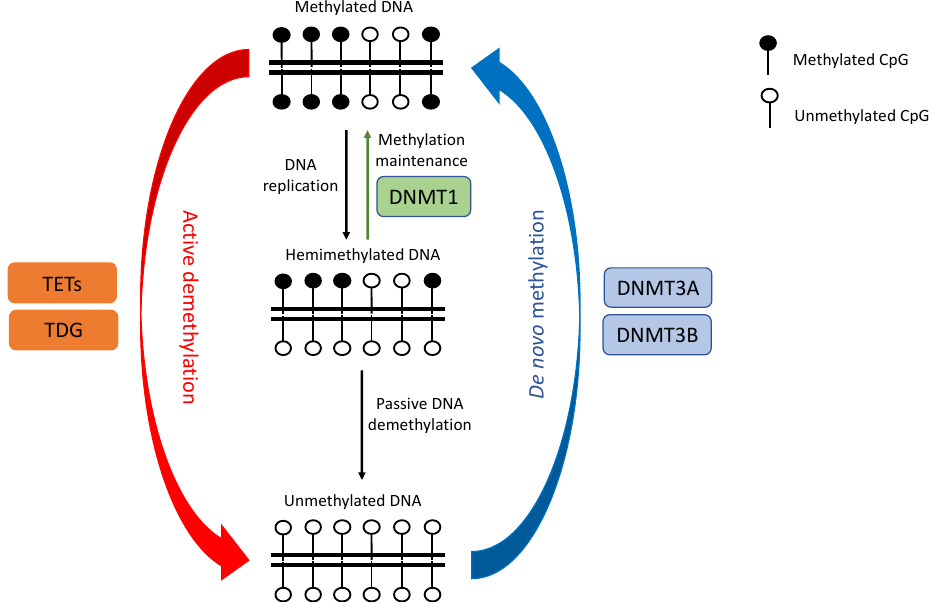
Figure 2. Schematic drawing of DNA methylation dynamics by DNMTs and TETs, adapted from Jeltsch and Jurkowska [42]. DNA methylation patterns consisting of both methylated and unmethylated CpGs could be created de novo by DNMTs, typically DNMT3A and DNMT3B. The methylation pattern is maintained during DNA replication by DNMT1 but could be lost through passive or active DNA methylation, which is facilitated by TETs and TDG enzymes. TETs: ten–eleven translocation enzymes; DNMT: DNA methyltransferase; TDG: thymine–DNA glycosylase.